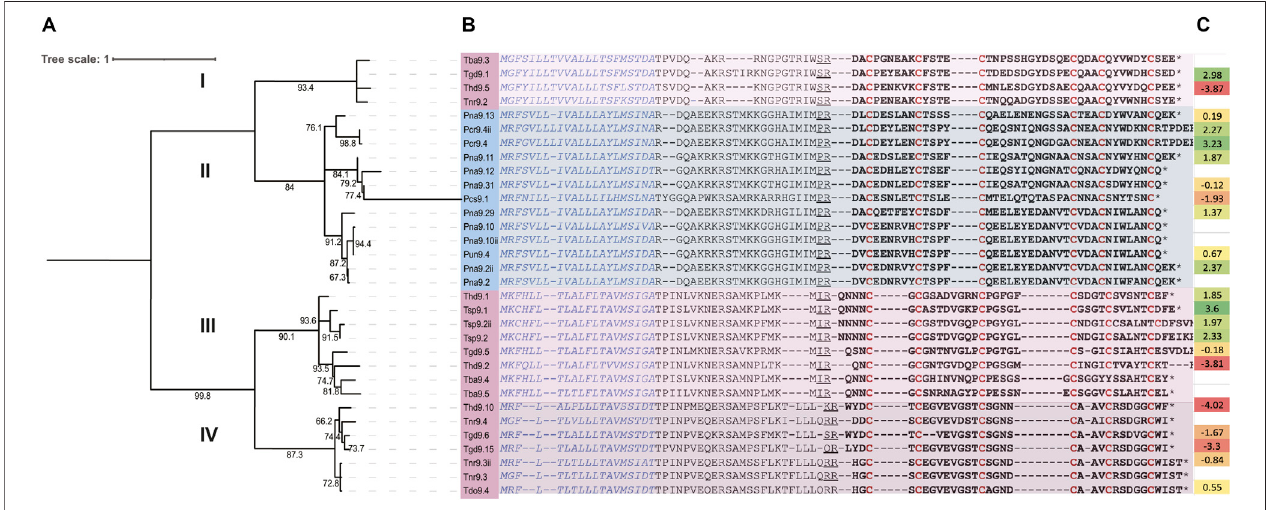
FIGURE 5 | Maximum likelihood phylogenetic tree with bootstrap support values showing the major divisions of P-like turripeptides identi fi ed in Turris and Purpuraturris speciesinto four discrete branches, labeled Clades I-IV. Purpuraturris isfound only inClade II. (A) phylogenetic tree, (B) multiple sequencealignmentused to generate the tree, (C) Expression levels of turripeptides identi fi ed in transcriptomes relative to the mean expression of HKG in the same transcriptome [log 2 (turripeptide TPM /HKG meanTPM ) of the housekeeping fold